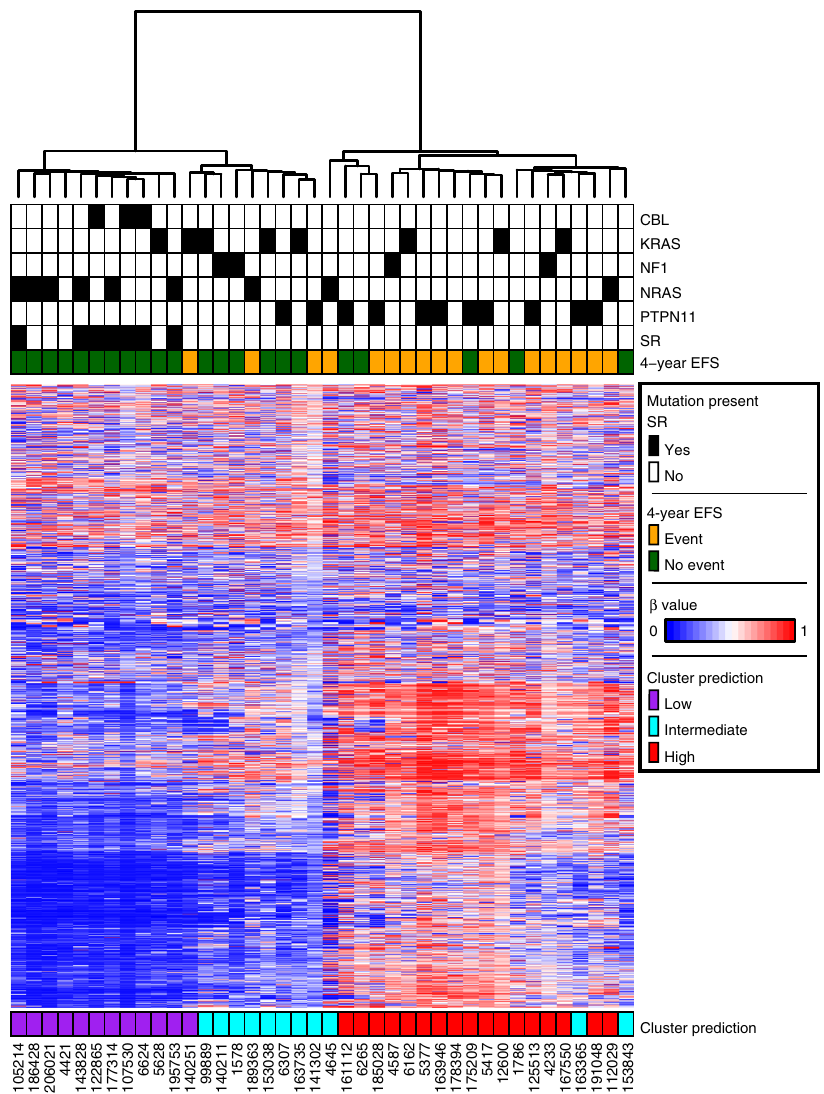
Fig. 2 DNA methylation predicts outcome in an independent cohort. Forty patients from EWOG-MDS were analyzed. Patients are displayed on the X axis and the same 1527 most variable CpG sites from the unsupervised discovery cohort analysis are displayed on the Y axis. Patients are assigned a cluster designation based on minimum distance to the centroid of the discovery cohort clusters. HgB F fetal hemoglobin, SR spontaneous remission, EFS event-free survival, β beta